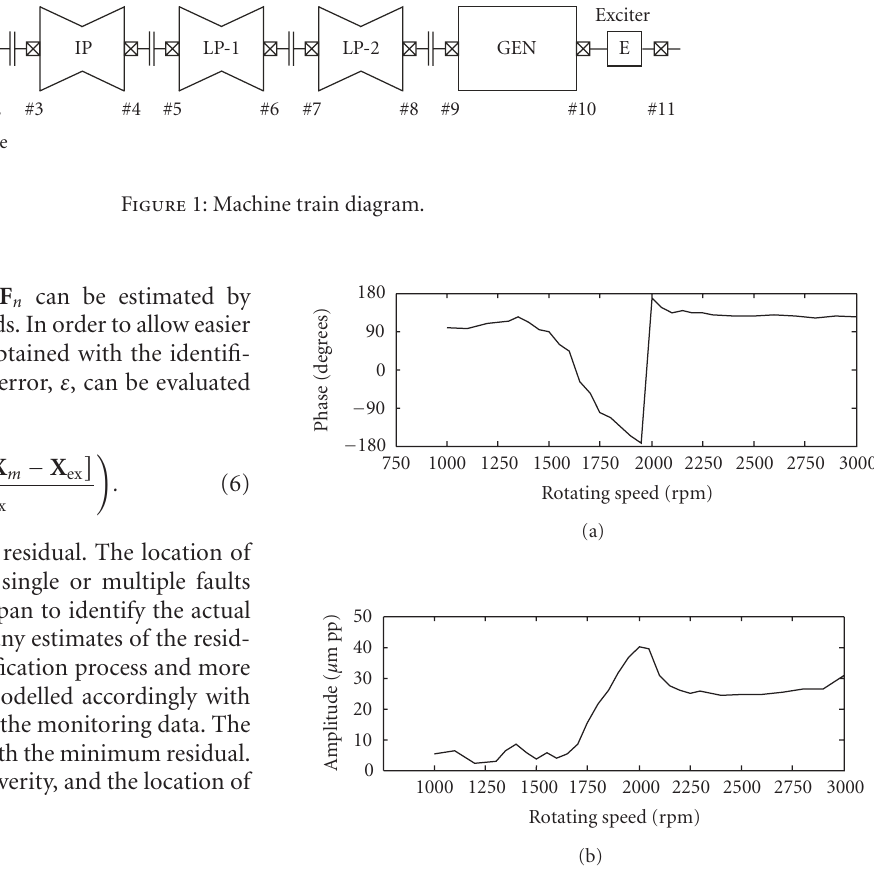
Figure 2: Bode plot of the 1X transient vibrations measured at bear- ing no. 2 during a normal runup.